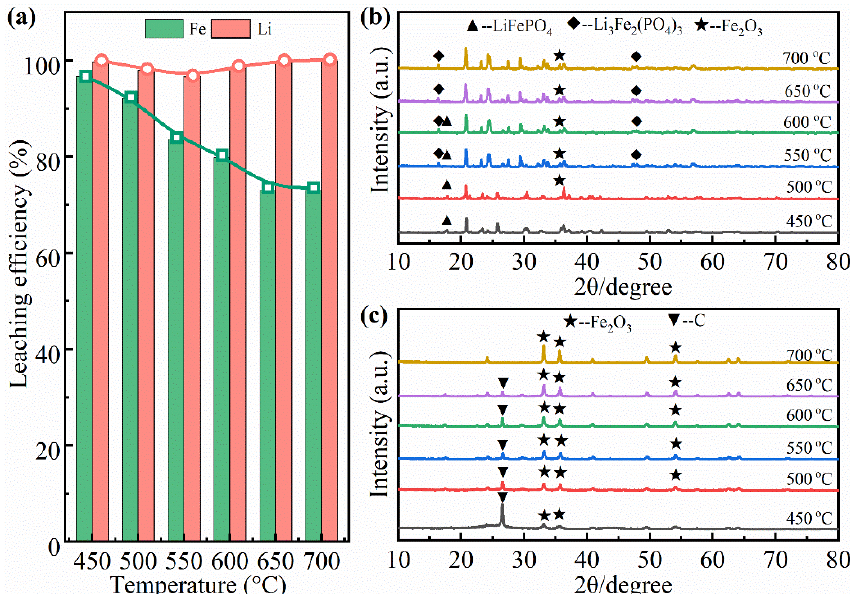
Figure 5. Leaching performance of cathode materials obtained at different roasting temperatures under the leaching conditions of 1.0 M H 2 SO 4 , S/L = 25 g/L, 70 °C, and 60 min. ( a ) Leaching efficiencies of Fe and Li; ( b ) XRD patterns of calcined cathode materials; ( c ) XRD patterns of sulfuric acid leaching residue.